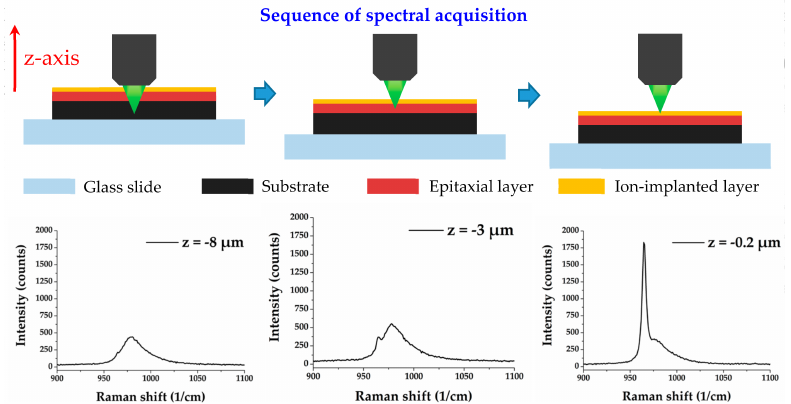
Figure 2. ( Top ) Schematic of the depth profiling (not drawn to scale in order to show the multilayer structure clearly). ( Bottom ) Raman spectra of the Al-doped sample A obtained by the 532 nm excitation line and 2400 lines / mm grating with the 100 × lens at di ff erent focal planes, corresponding to Raman signals from the three di ff erent layers. The step of depth profiling is 0.2 µ m. The origin of the z-axis (z = 0 µ m) is located at the top of ion-implanted